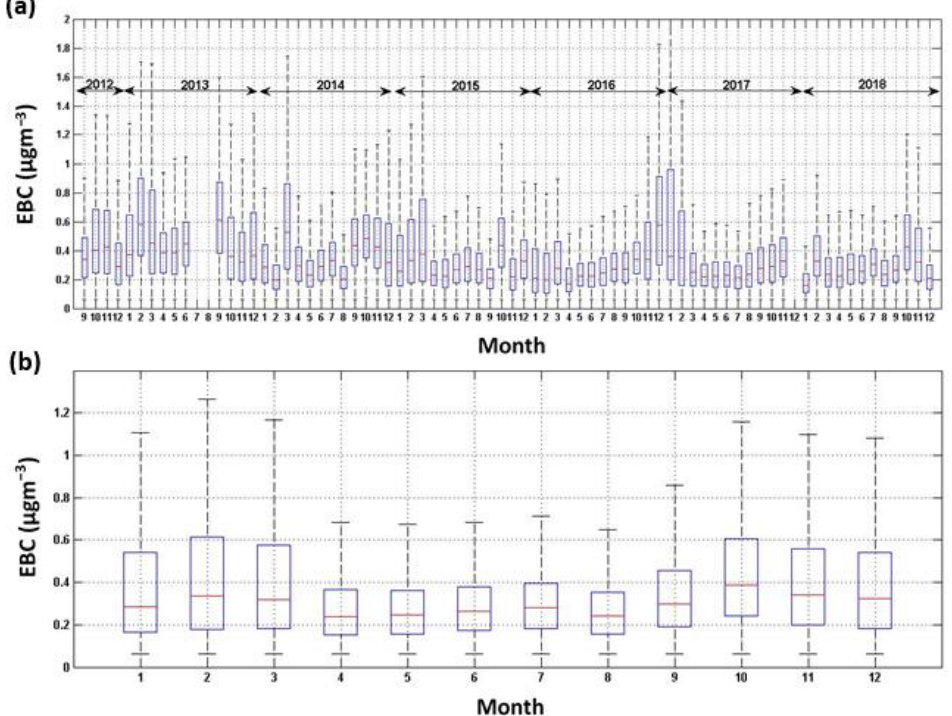
Figure 3. ( a ) Evolution of the equivalent black carbon (EBC) concentrations over the entire measurement period and ( b ) seasonal. Red lines represent the median value, the bottom and top sides of the boxes symbolize the 25th and 75th percentile, respectively. The length of the whiskers represents 1.5 × interquartile range which includes 99.3% of the data.